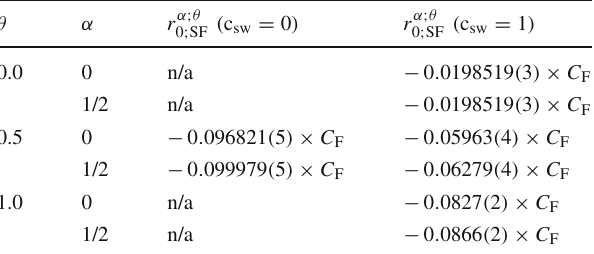
Table 1 Finite parts of one-loop renormalization constants in the scheme specified by the parameters θ and α for the unimproved and O ( a ) -improved fermion actions